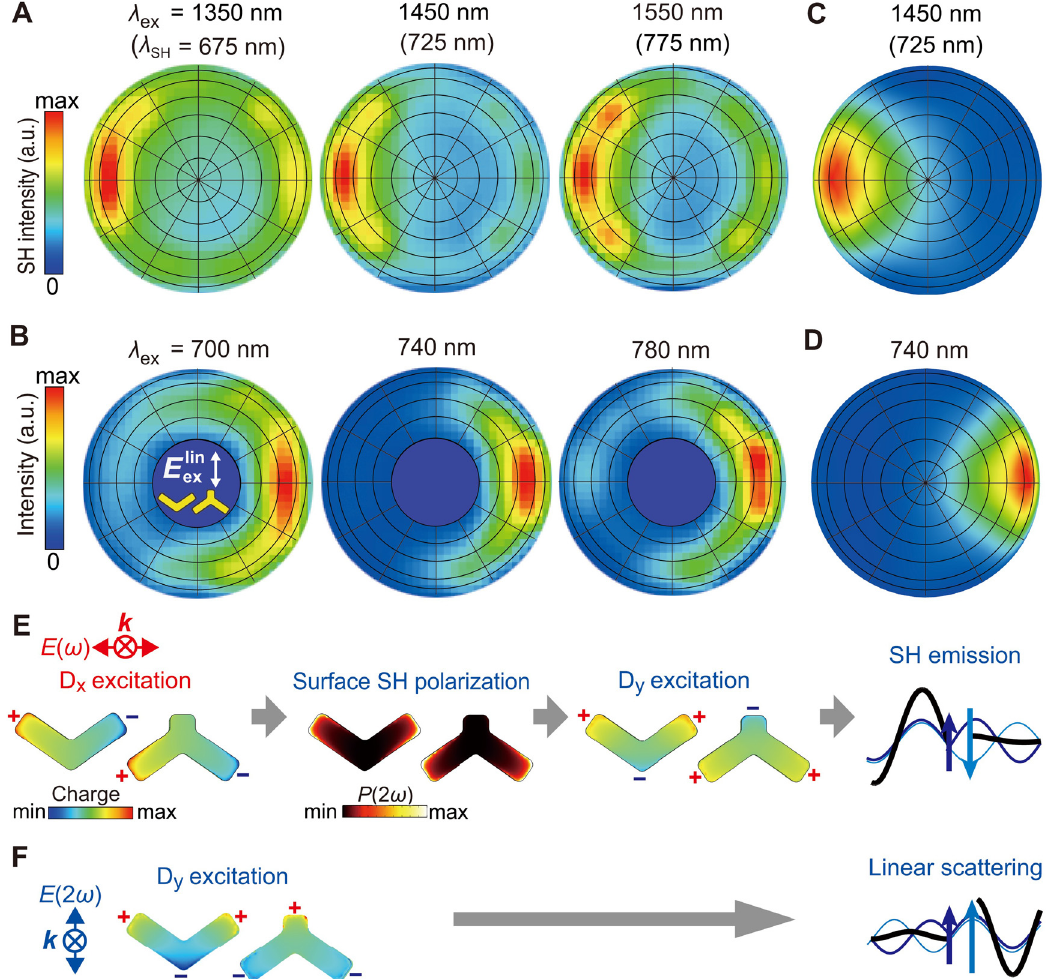
Figure 4: (A and B) Measured angular distributions of SH emission and linearly scattered light, respectively, from a pair of V- and Y-elements with a tail length of 25 nm (see Figure 3B) at different wavelengths of incident light. λ ex and λ SH denote the excitation and SH wavelengths, respectively. In (B), the D y mode of the antenna was directly excited by y -polarized light illumination. The antenna directivities of both radiations were maximized in the wavelength range between the D y resonances of the V- and Y-elements. The SH emission in (A) and linear scatteringin(B)occurredinoppositedirections.(CandD)CorrespondingtheoreticalangulardistributionsoftheSHemissionat λ ex =1450nm and the linearly scattered light at λ ex = 740 nm, respectively. (E and F) Charge and SH polarization distributions in the processes leading to unidirectional radiation of (C) and (D),